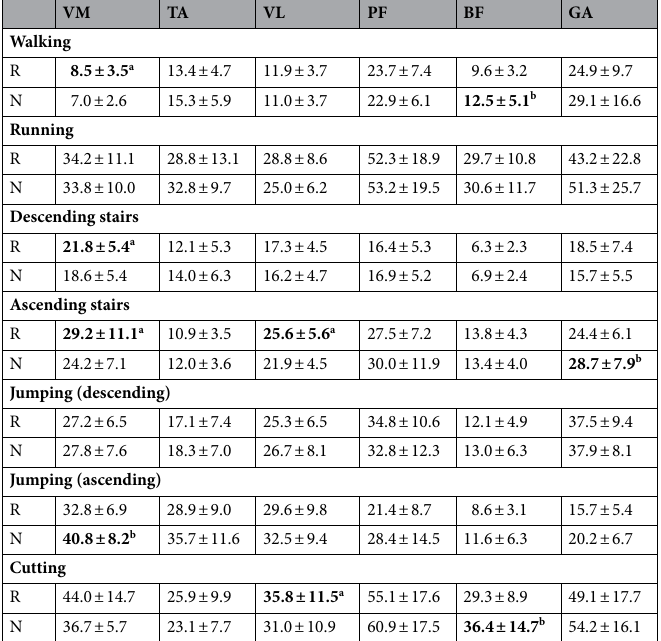
Table 4. Mean activation (% MVC) of six muscles during each functional task. BF biceps femoris, GA gastrocnemius, MVC maximum isometric voluntary contraction, N normal shoes, PF peroneus longus, R rocker-soled shoes, TA tibial anterior, VL vastus lateralis, VM vastus medialis. a Muscle activation in rocker- soled shoes was significantly larger than in normal shoes ( p < 0.007). b Muscle activation in normal shoes was significantly larger than in rocker-soled shoes ( p < 0.007). Significant values are in